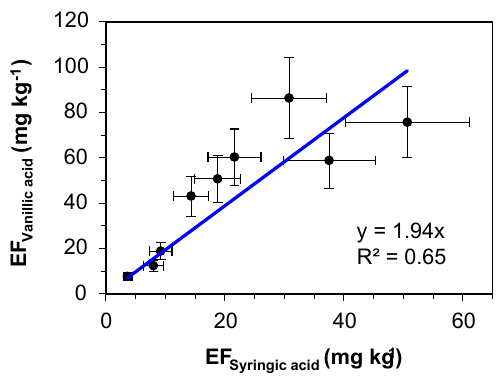
Figure 7. Emission ratios of vanillic acid to syringic